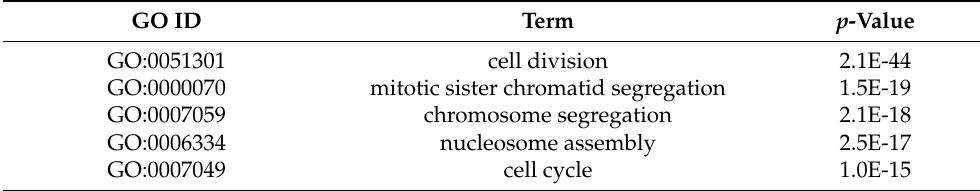
Table 6. Top 5 Gene Ontology (GO) terms among 100 commonly upregulated transcripts by si BNAT1 #A and #B. GO ID. GO